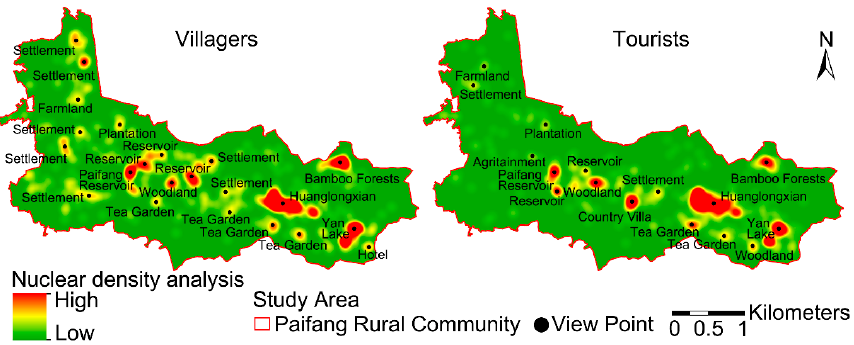
Figure 8. Comparison of the spatial distribution density of the social value points marked by the villagers and tourists in the Paifang rural community.